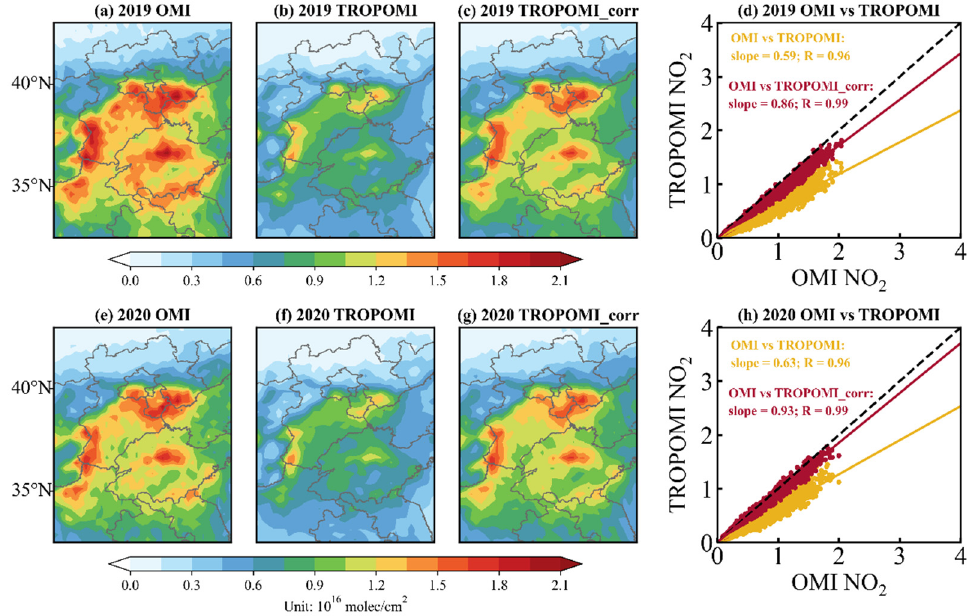
Figure 5. Comparisons of annual tropospheric NO 2 VCDs over NCP from OMI and TROPOMI. NO 2 VCDs derived from OMI and TROPOMI in 2019 and 2020 are shown in panels ( a , b , e , f ), respectively, along with the corrected TROPOMI shown in panels ( c , g ). Scatter plots of TROPOMI tropospheric NO 2 vs. OMI NO 2 and corrected TROPOMI NO 2 vs. OMI NO 2 in 2019 and 2020 are shown in panels ( d , h ), respectively.